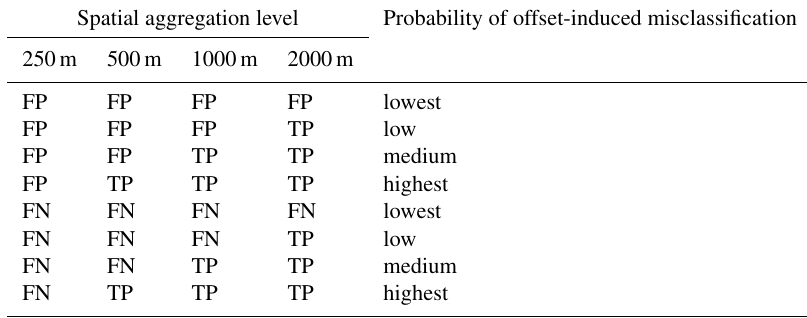
Table E1. Cross-scale disagreement trajectories and assigned offset-induced misclassification probability.